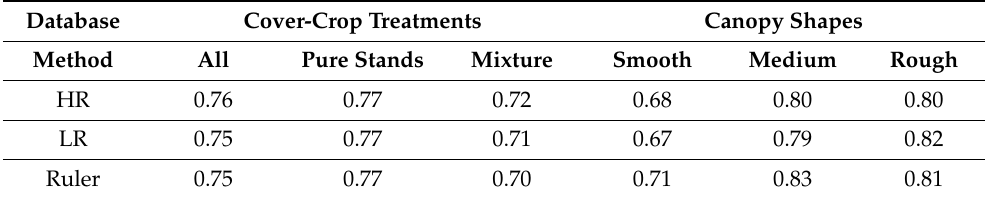
Table 3. Coefficients of determination of regression analyses between cover-crop biomass yield and canopy height obtained using ruler, low-resolution (LR), and high-resolution RGB (HR) images for different cover-crop compositions, resulting in 3 canopy shapes. Database Cover-Crop Treatments Canopy Shapes Method All Pure Stands Mixture Smooth Medium Rough